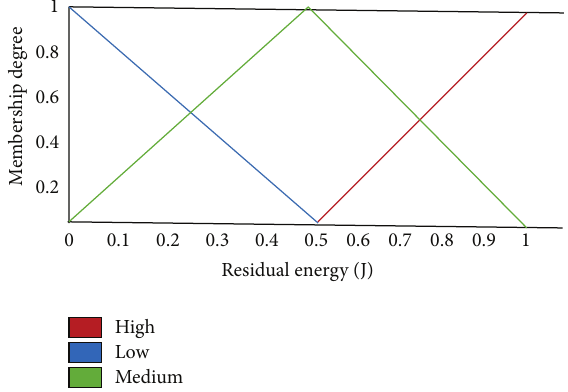
Figure 3: Fuzzy set for fuzzy input variable residual energy.